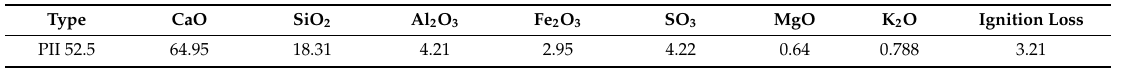
Table 3. Chemical compositions of Portland cement/wt